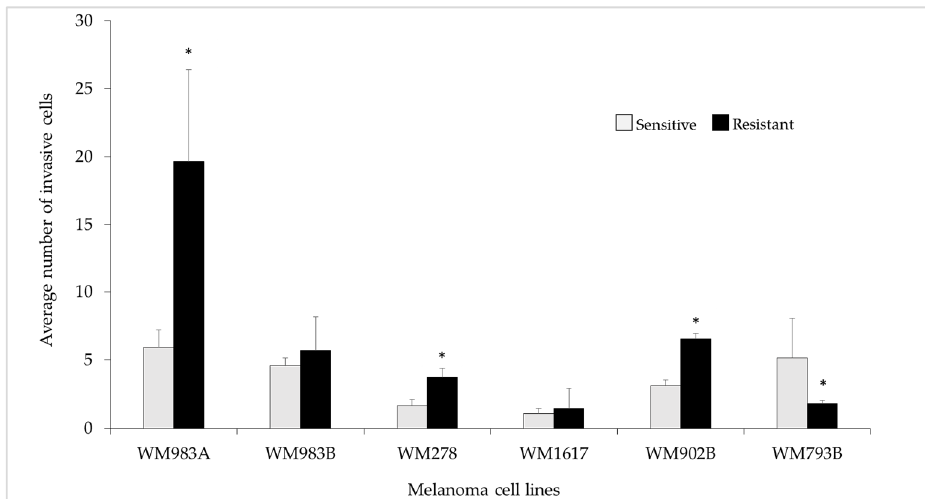
Figure 3. Invasive potential of the ENCO+BINI-resistant melanoma cell lines. Light grey columns correspond to the sensitive, and black columns represent the inhibitor-resistant cell lines. The data are presented as the mean ± standard deviation ( ± SD) of three independent experiments. The asterisks indicates a statistically significant difference (Mann–Whitney–Wilcoxon test; * p <